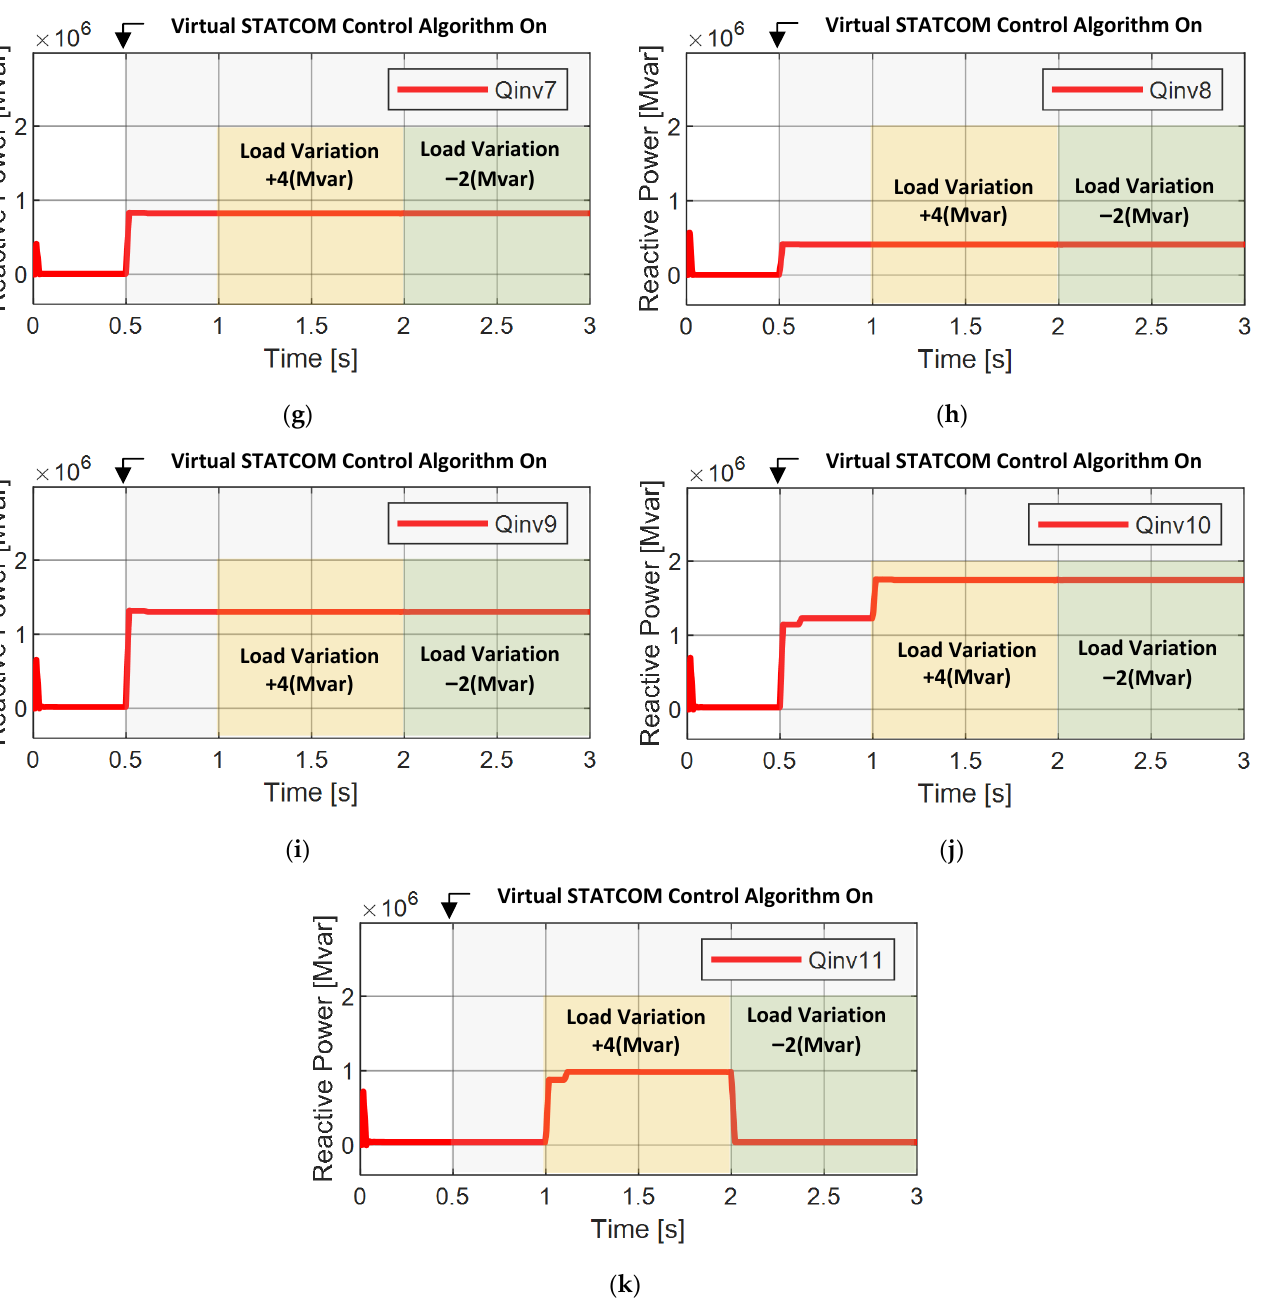
Figure 11. 11 Reactive Power Compensation Amount of Virtual STATCOM Inverter 1~: ( a ) Inverter 1, ( b ) Inverter 2, ( c ) Inverter 3, ( d ) Inverter 4, ( e ) Inverter 5, ( f ) Inverter 6, ( g ) Inverter 7, ( h ) Inverter 8, ( i ) Inverter 9, ( j ) Inverter 10, ( k ) Inverter 11. In the time of 0~0.5 (s), the Virtual STATCOM control algorithm does not operate, so the Virtual STATCOM inverters are not outputting the reactive power. The control algorithm operates at 0.5 (s), and the reactive power compensation is carried out in consid- eration of the distance of the inverter to the maximum reactive power output. The reactive power compensation is carried out by dividing reactive power 5.8 (Mvar) generated in PCC by inverters 1, 2, 7, 8, 9, and 10. Inverter 1 compensated 0.4 (Mvar) reactive power, Inverter 2 compensated 1.35 (Mvar), Inverter 7 compensated 0.9 (Mvar), Inverter 8 compensated 0.45 (Mvar), Inverter 9 compensated 1.4 (Mvar), and Inverter 10 compensated 1.2 (Mvar). In Load Variation 1 (s), inverters 1, 2, 3, 7, 8, 9, 10 and 11 divided PCC reactive